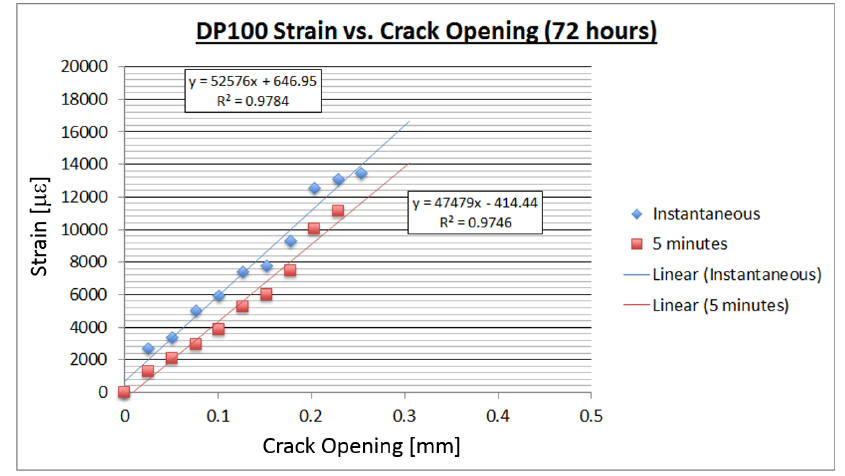
Figure 11. DP100 crack opening vs. strain after 72 hours.